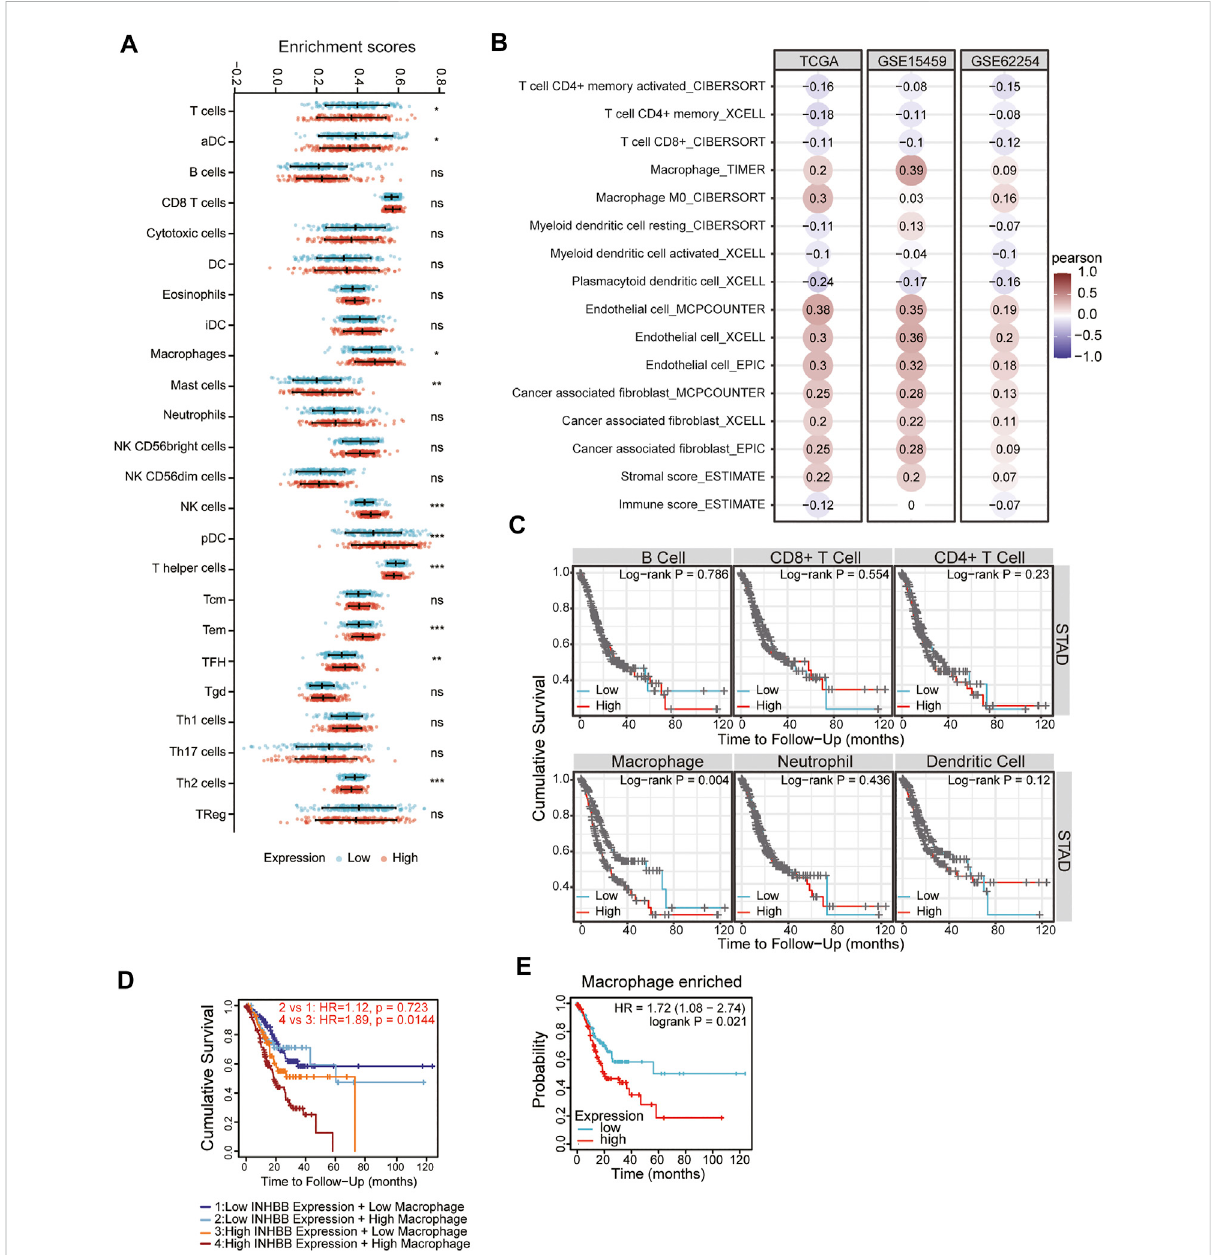
FIGURE 7 Correlation between immune in fi ltration and INHBB expression in GC. (A) INHBB expression and in fi ltration of 24 immune cell subtypes, (B) INHBB expression and immune in fi ltration data from TCGA and GEO, (C) Survival analysis for immune in fi ltrates and INHBB expression, (D) Survival analysis for differential expression of INHBB and macrophage in fi ltration, (E) Survival analysis for INHBB expression and macrophage enriched in fi